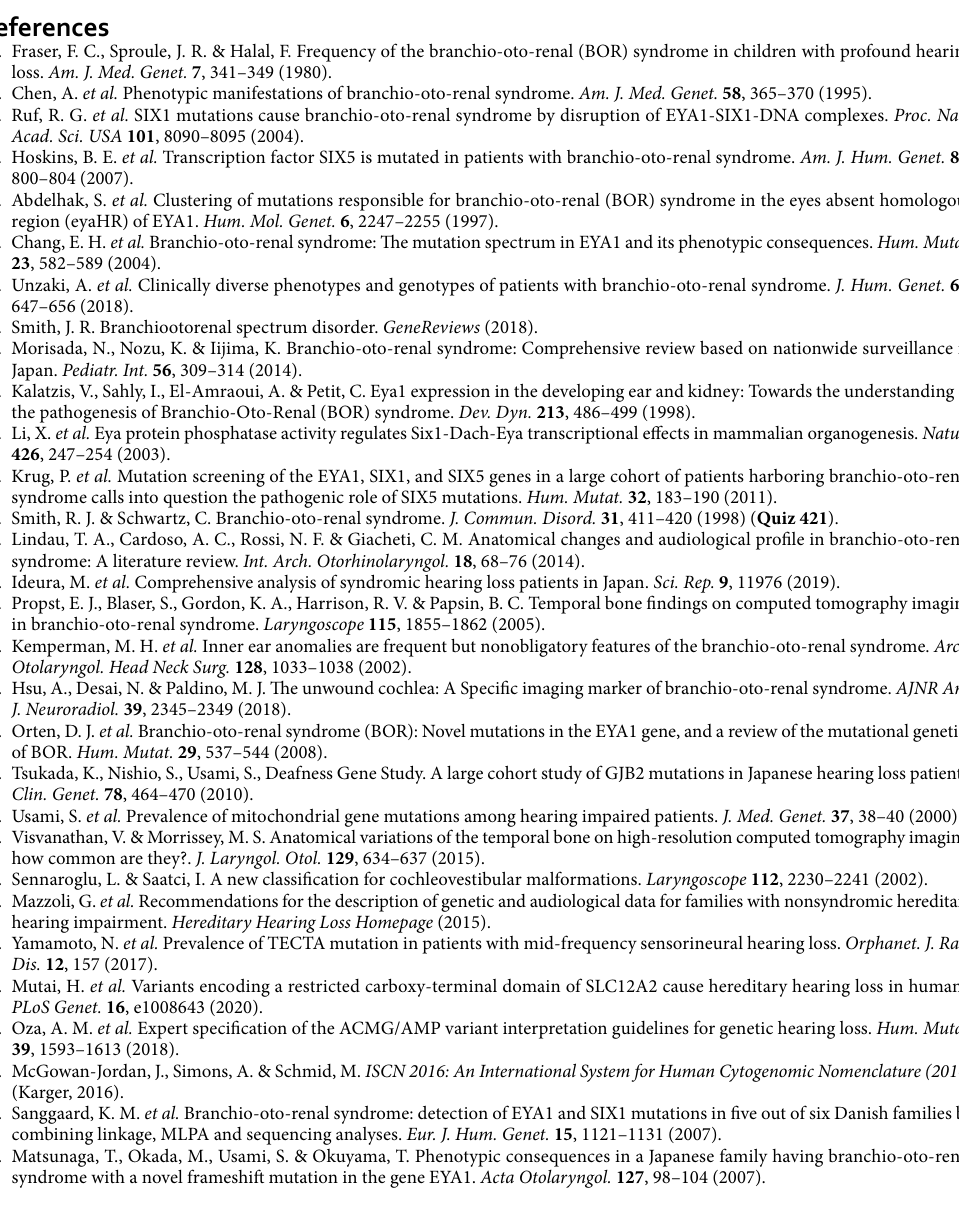
Supplementary Table S3. For subjects where no P/LP variants of EYA1 was identified, P/LP variants screening of exons 1 and 2 of SIX1 and exons 1–3 of SIX5 was conducted by Sanger sequencing. For two patients (Family 10, 23), genomic DNA was subjected to targeted resequencing of 154 deafness genes using Nextseq 500 (Illumina, CA, USA), and the resulting data were analyzed as previously described 26 . The pathogenicity of each genetic variant was evaluated according to the guidelines by ClinGen Hearing Loss Clinical Domain Working Group 27 . For subjects where no P/LP variants of EYA1 were identified by direct sequencing, MLPA was conducted to iden- tify copy number variants of EYA1 , using the SALSA MLPA KIT (P153; MRC-Holland, Amsterdam, the